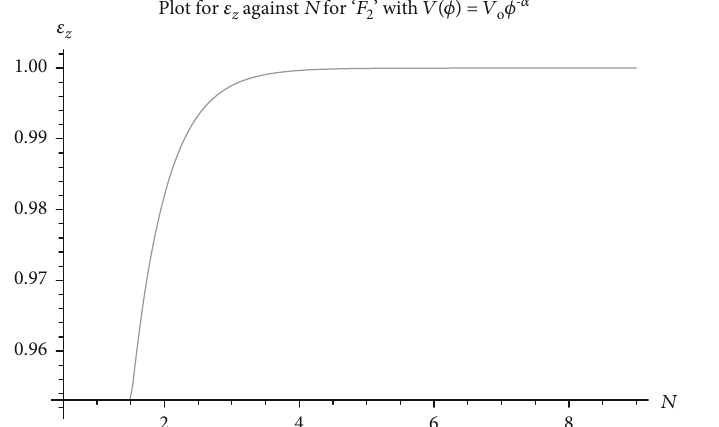
Figure 22: Shows the variation of perturbations along the z -axis ( ϵ